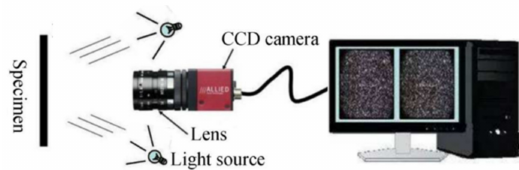
Figure 3. Strain measurement methods.